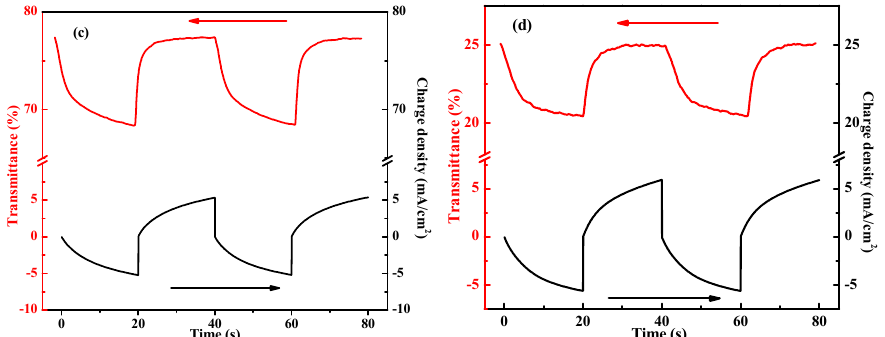
Figure 5. In situ transmittance (red) and corresponding chronocoulometry (black) of ( a ) pristine PANI film, ( b ) graphene/PANI film, ( c ) WO 3 /PANI film, and ( d ) WO 3 /graphene/PANI film at 633 nm in 0.5 M H 2 SO 4 aqueous solution. The tests were conducted under a square-wave voltage of 0.8 and − 0.2 V with a pulse width of 20 s.